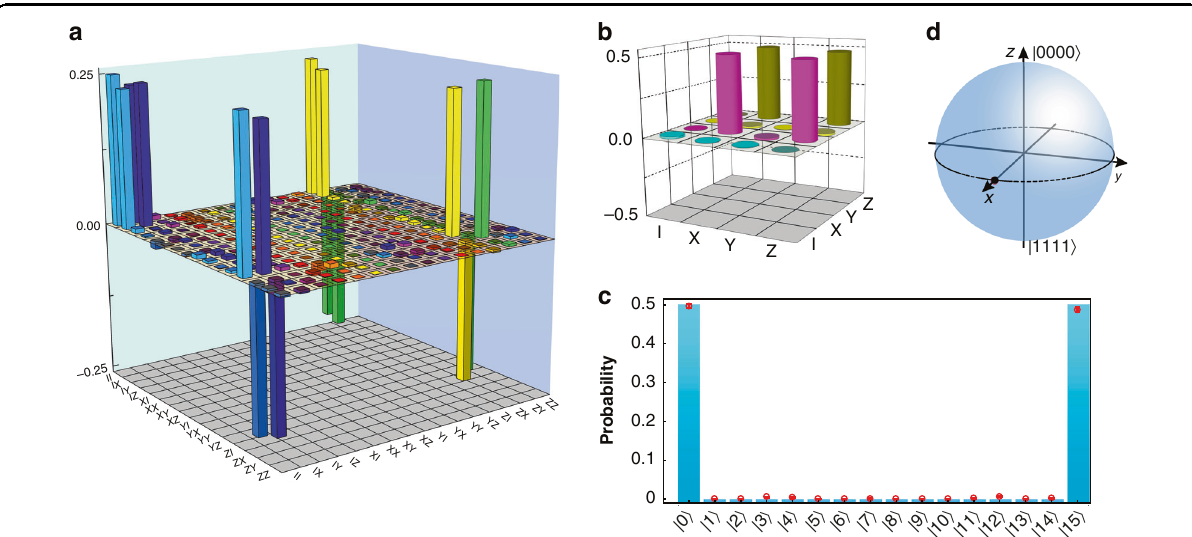
Fig. 3 Experimental quantum process tomography of operations on physical qubits and initial logical state preparation. a , b Real parts of the experimentally reconstructed density matrix of CNOT and Hadamard operations on physical qubits, respectively, based on the Pauli operators {I, X, Y, Z}. c Detected probabilities of the complete basis for coincidence count of logical state |00 〉 l . The basis is represented with integers (e.g., |5 〉 = | 0101 〉 ). Histograms and red hollow points correspond to the theoretical and experimental results. d Logical state 00 j i l ¼ 0000 j i þ 1111 j ið Þ = represented in the Bloch sphere on basis {|0000 〉 , |1111 〉 }. Black and pink points represent the theoretical prediction and experimental result,